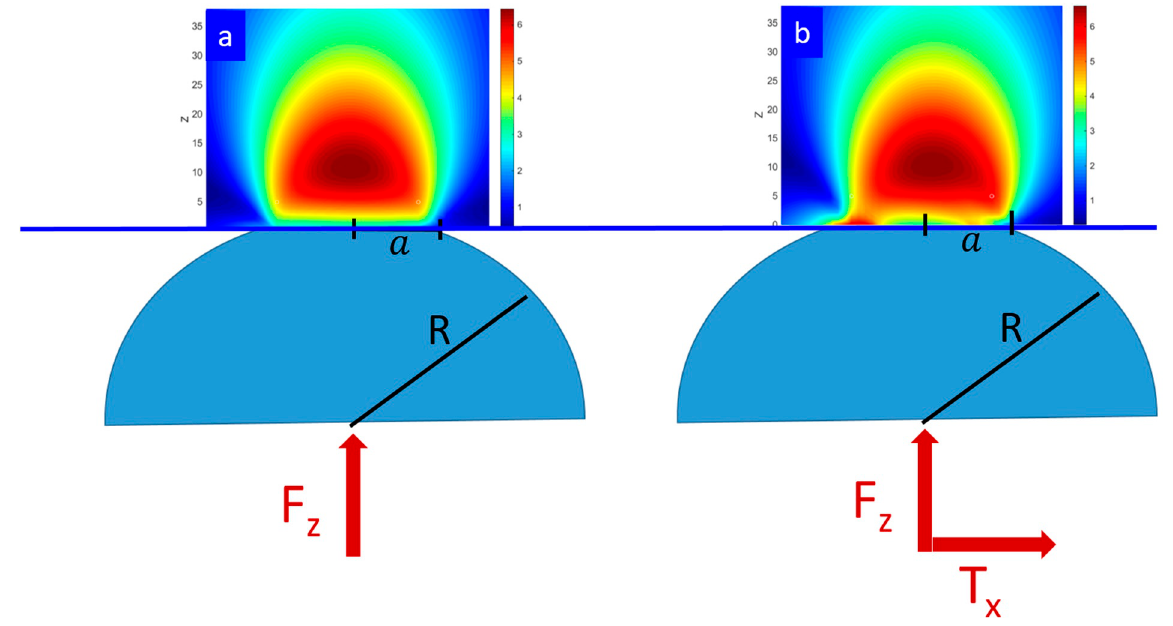
Figure 2. ( a ): Hertzian contact and resulting deviatoric strain field inside the flat body compared to the same configuration ( b ): but with a friction coefficient µ = 0.3 at the interface between the two bodies and with a tangential load T x = 0.24 F z .